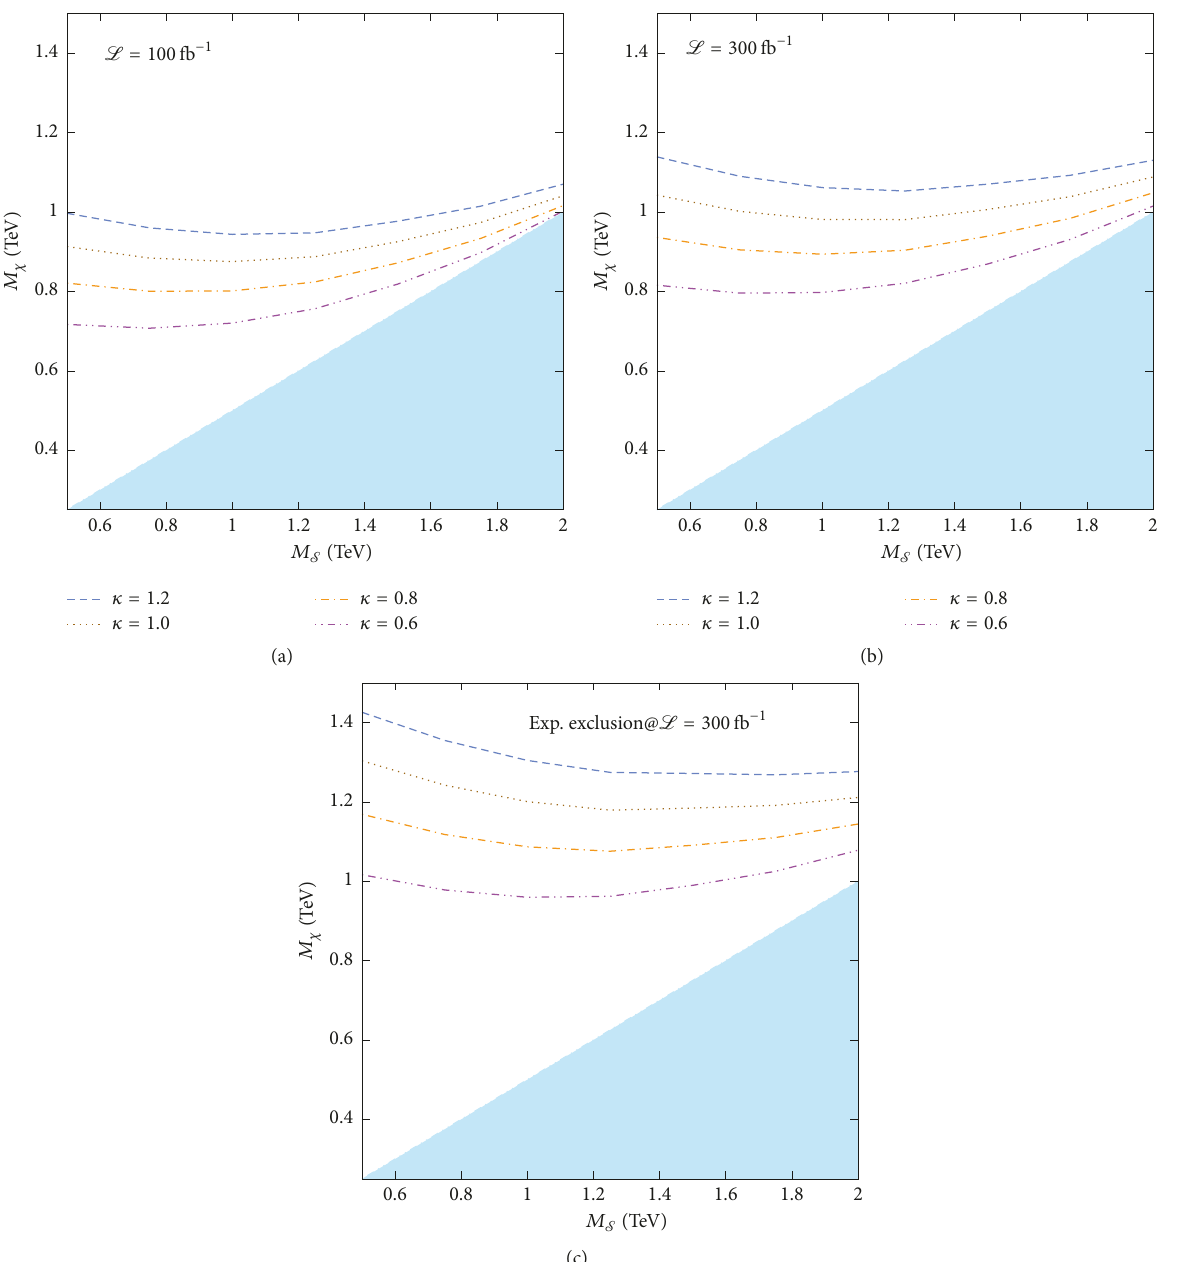
Figure 7: The 5𝜎 discovery contours in 𝑀 S - 𝑀 𝜒 plane for different 𝜅 at 13TeV LHC for (a) 100 fb −1 and (b) 300 fb −1 integrated luminosity. (c) The expected 2𝜎 exclusion plot for L = 300 fb −1 . The sky-blue region cannot be probed in our analysis as we assume 𝑀 𝜒 > 𝑀 S /2